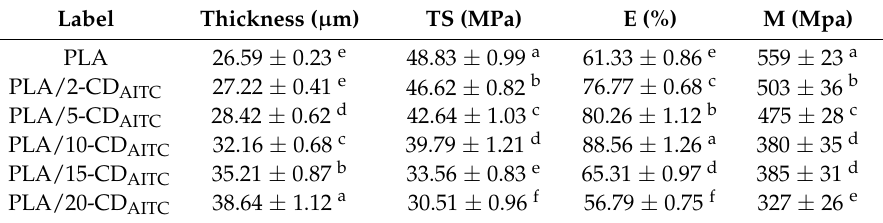
Table 2. Mechanical properties of PLA films with different amounts of β -CD/AITC. Label